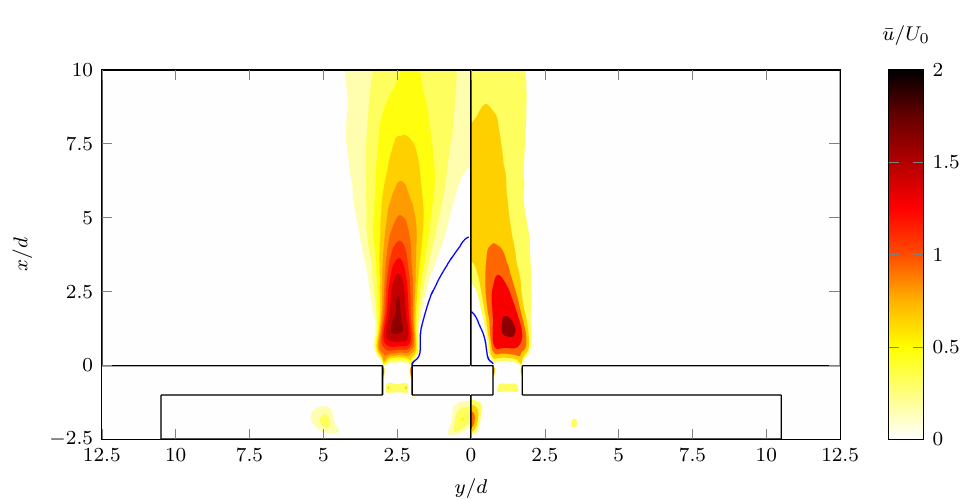
Figure 14. Contour plot of the time-averaged streamwise velocity field ¯ u , z = 0. s o / d = 5 ( left ), s o / d = 2.5 ( right ). A blue contour line ¯ u = 0 is depicted to highlight the recirculation zones.